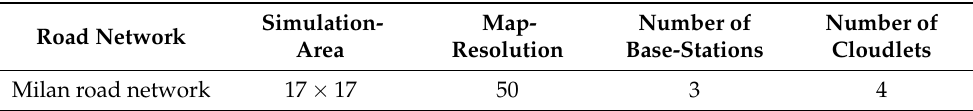
Table 5. Mobility